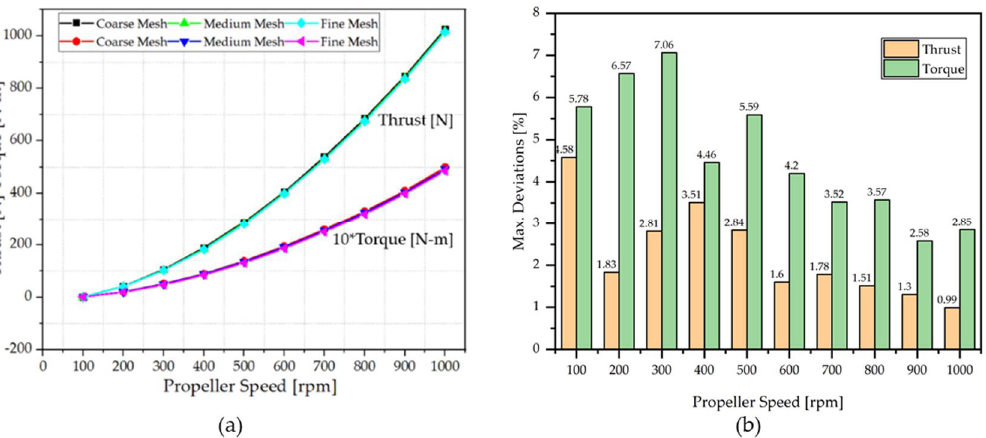
Figure 6. Mesh independence analysis results ( a ) torque and thrust among three mesh resolutions ( b ) maximum deviations attained at each propeller speed.